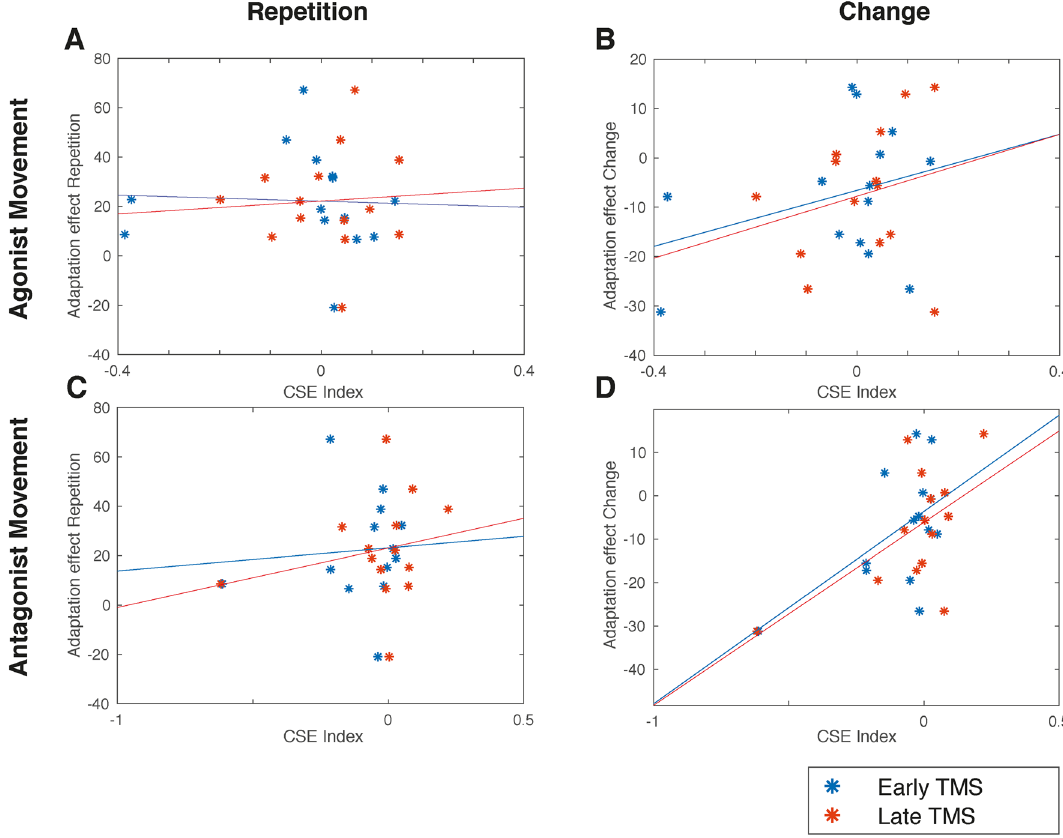
Figure 4. Conflict-adaptation effect (RT for cI – RT for iI trials) as a function of the CSE index (MEPincongruent − MEPcongruent)/(MEPincongruent + MEPcongruent) in each of the 14 subjects. ( A – C ) No correlation is evident between agonist or antagonist movement and CSE index in repetition trials ( A , C ), nor with agonist movement in change trials ( B ). ( D ) However, the relative strength of the CSE index for the antagonist muscle correlated significantly with the ‘pure’ behavioral adaptation effect (i.e., without repetition) across the subjects. Thus the antagonist CSE index is a reliable predictor of the conflict-adaptation effect for both early and late TMS times (R2 = 0.3 and R2 = 0.36; p < 0.05). See Table 1 for the trial characteristics used to calculate the CSE indexes in ( A – D